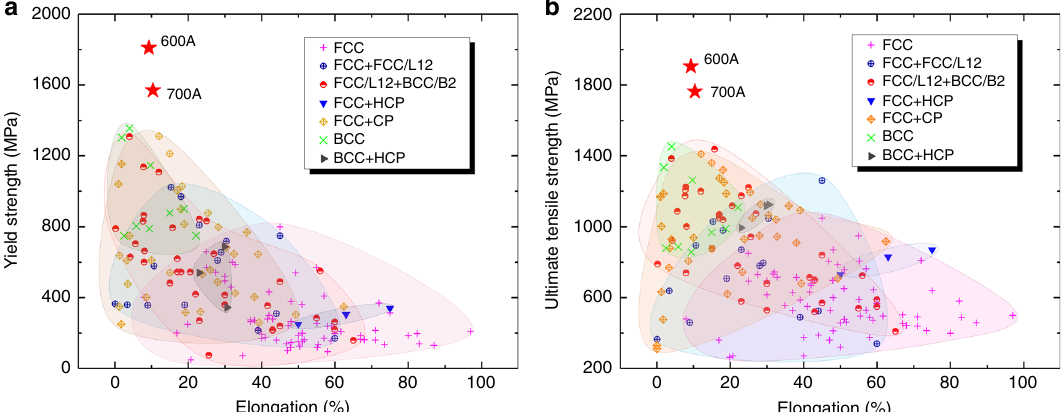
Fig. 4 Comparison of our developed HEAs (600 A and 700 A) with existing HEAs. a , b Maps of elongation versus YS and UTS of HEAs reported previously at room temperature, respectively, where HCP and CP refer to the phases with hexagonal close-packed and complex lattice structures (e.g. σ and μ phases), respectively. The data of the tensile properties of reported HEAs were acquired from Supplementary